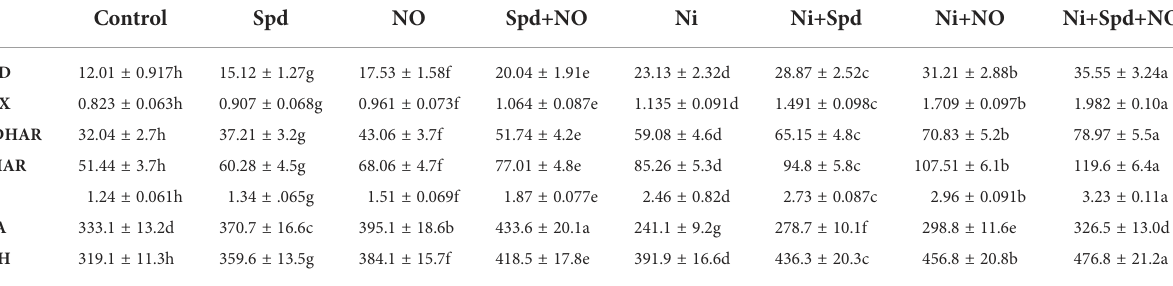
TABLE 2 Effect of nitric oxide (NO; 50 µM) and spermidine (Spd; 100 µM) supplementation on the activity of superoxide dismutase (SOD), ascorbate peroxidase (APX), monodehydroascorbate reductase (MDHAR), dehydroascorbate reductase (DHAR), and glutathione reductase (GR) and the contents of ascorbate (AsA) and reduced glutathione (GSH) in Solanum lycopersicum L. treated with nickel